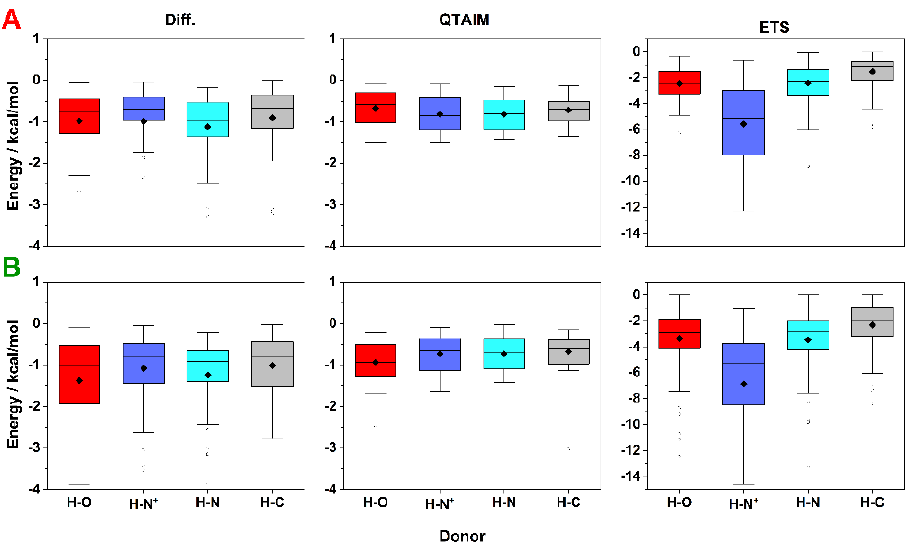
Figure 5. Box plots showing the distribution of the stabilization energy for HBs containing fluorine bonded to an ( A ) aliphatic or ( B ) aromatic carbon. A comparison is made for the individual donor groups (OH, + NH, NH, and CH) as well as the calculation approaches used (Diff, QTAIM, and ETS). The hydroxyl donor occurs in the side chains of three amino acid—tyrosine (TYR), threonine (THR), and serine (SER). The phenolic hydroxyl group (TYR) is significantly more acidic (pK a of about 9.8 in polypeptides) than the aliphatic hydroxyl group (SER